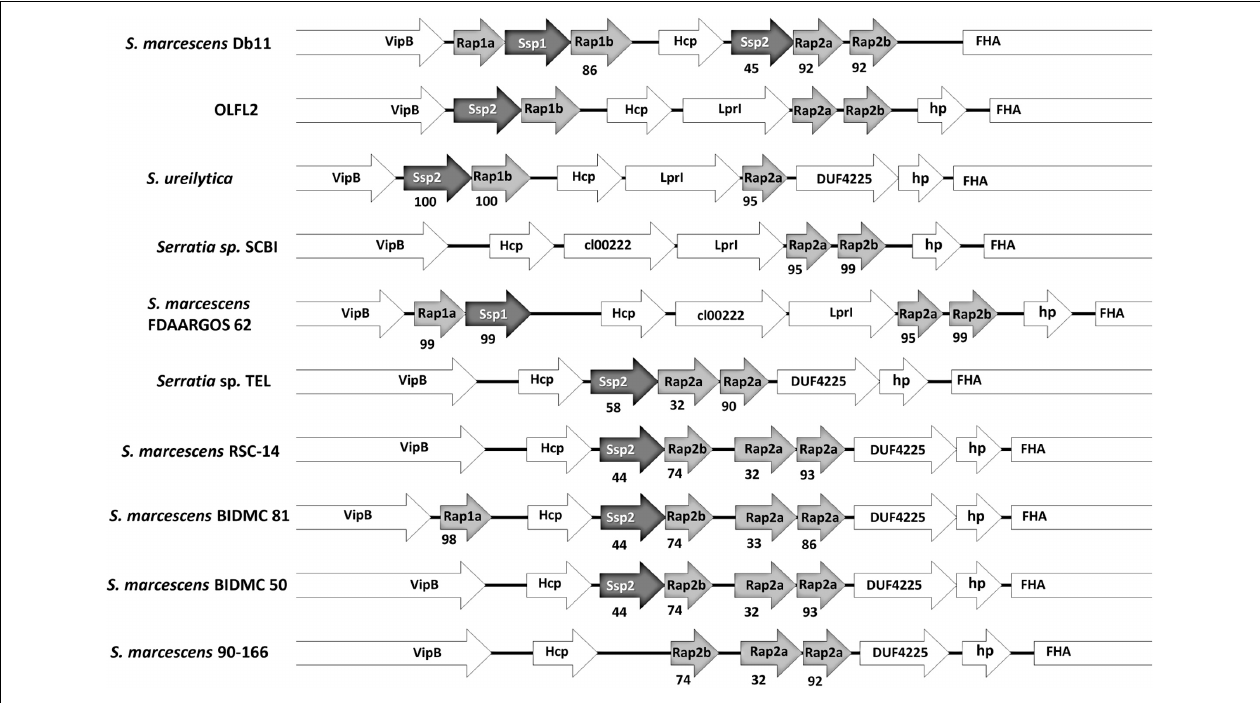
FIGURE 6 | Synteny map of the Ssp–Rap locus in Orius -associated Serratia (OLFL2), compared to strains from the Serratia SCBI complex and S. marcescens DB11. Protein product names are shown, and sequence identity to corresponding ortholog in OLFL2 or S. marcescens DB11 is indicated below each gene. Well-conserved genes (VipB, Hcp, and Fha) are also shown. Uncharacterised encoded proteins are shown as hypothetical protein (hp) or named based on predicted conserved domains content (LprI: cl26926, DUF4225,